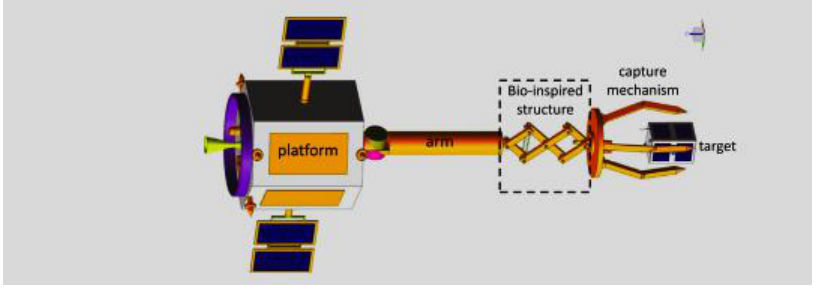
Figure 25. An in-orbit capture, with the BIQS system to suppress post-capture vibrations [93]